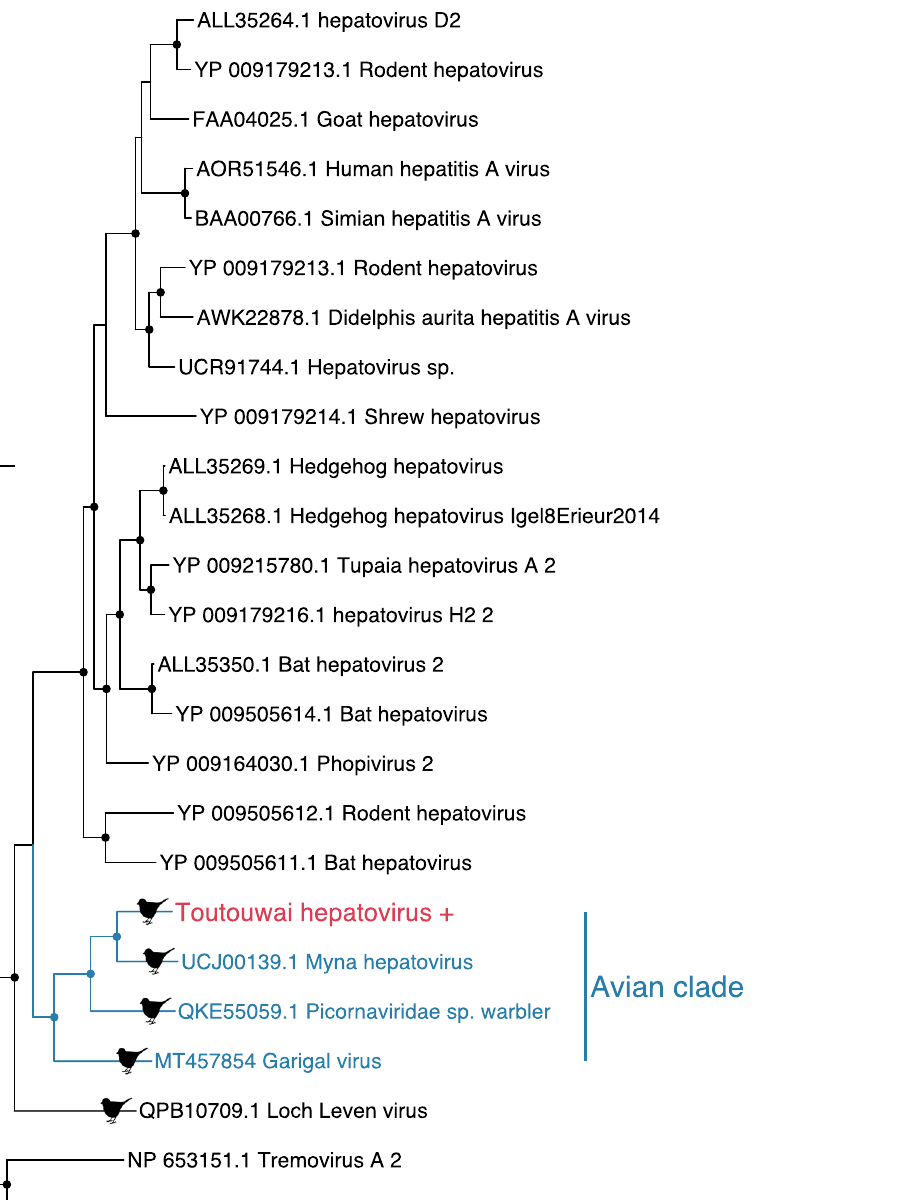
’ after the name. The avian clade is +